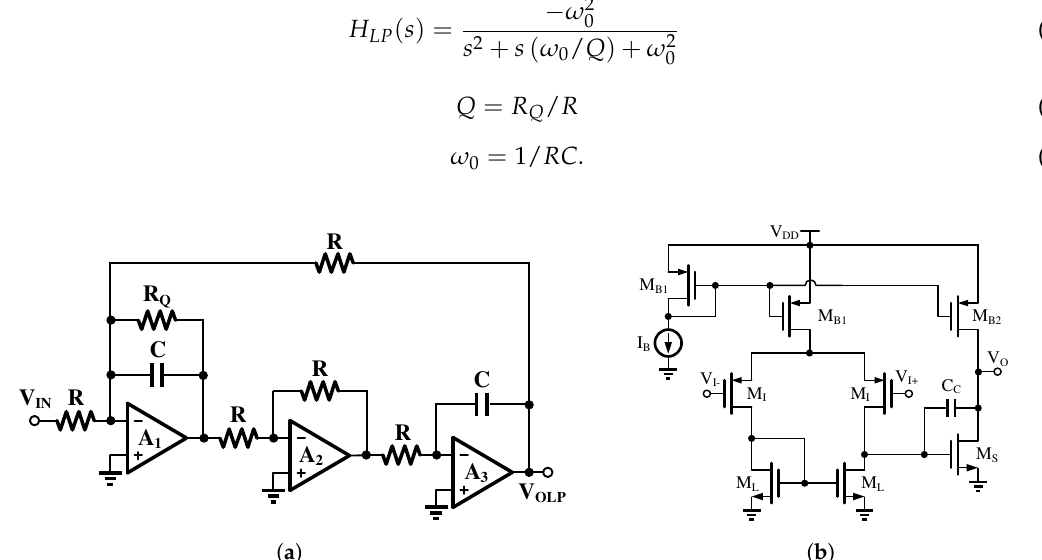
Figure 5. Active-RC second order filter under design ( a ) circuit topology. ( b ) Transistor level schematic of the second order internally compensated